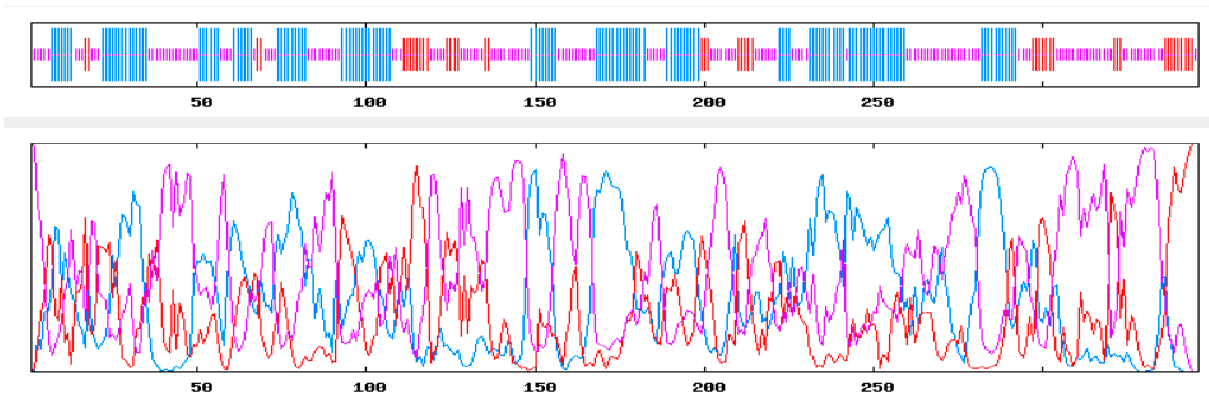
Figure 3. GOR4 result (dark blue is denoting alpha helix, light blue is denoting pi helix, dark pink is denoting beta bridge, red is denoting extended strands).